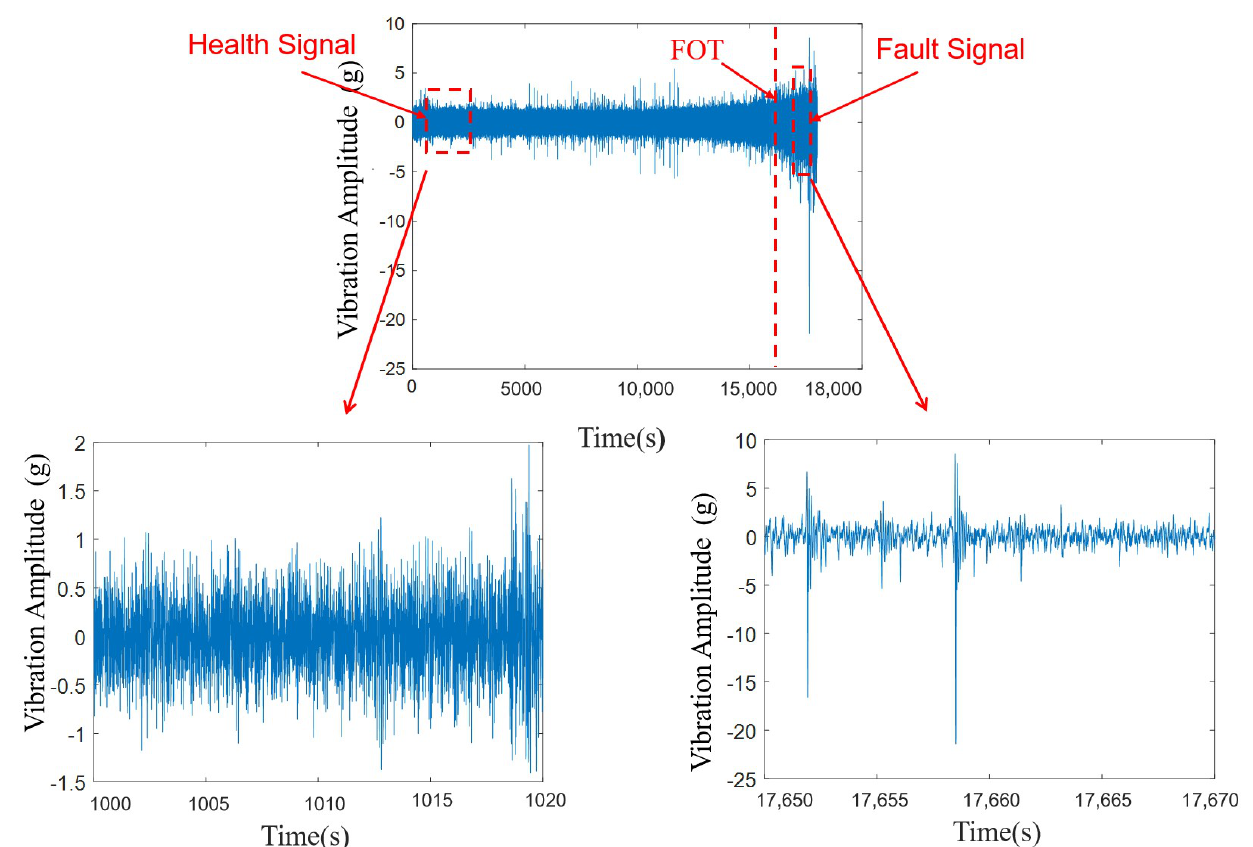
Figure 6. Time domain waveform and the Failure Occurrence Time (FOT) of the raw signal. The middle one is the time domain waveform of test bearing1_3. The signal to the left of FOT is the healthy bearing signal, and the one to the right of FOT is the fault